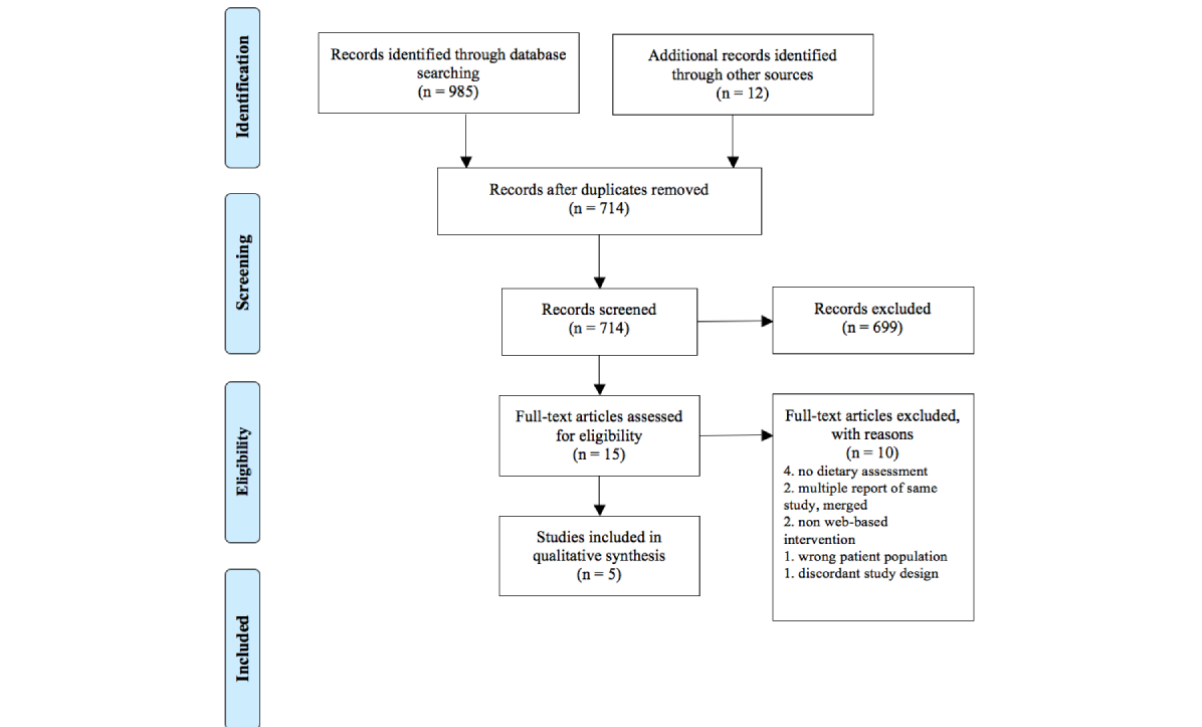
Figure 1. Prisma Flow